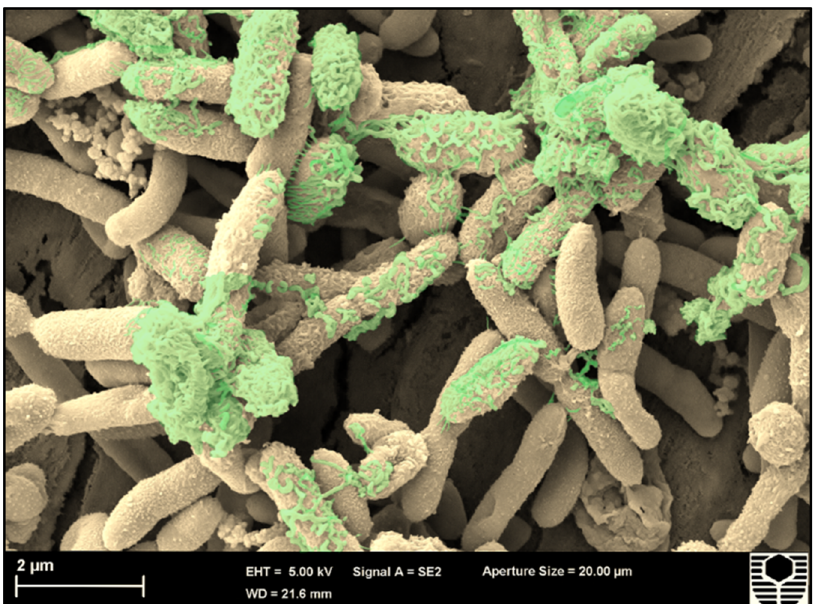
Fig. 2 SEM of a marine bio fi lm characterised by dense cell living arrangement and EPS. SEM micrograph of Klebsiella pneumoniae bio fi lm formation on carbon steel (AISI 1030) in arti fi cial seawater, where structures resembling EPS (green) cover bio fi lm cells within 24